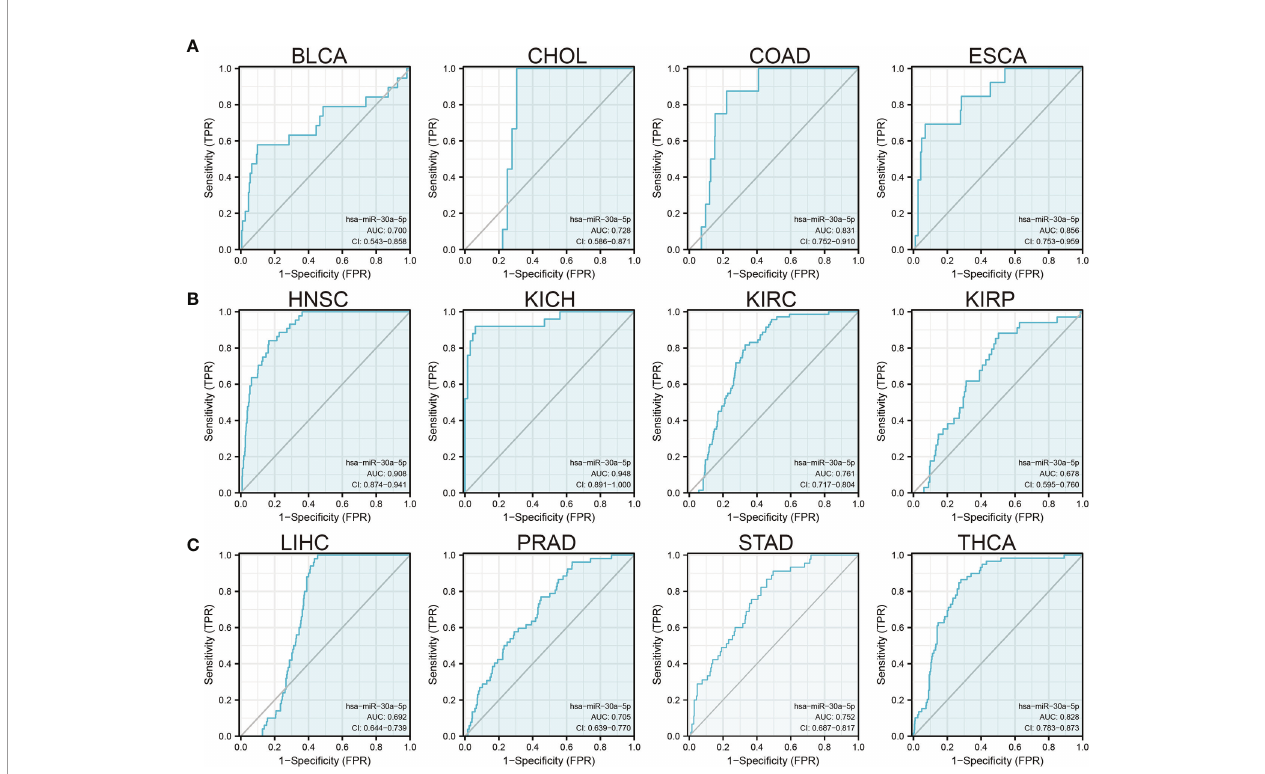
FIGURE 2 | Analysis of the ROC curve for miRNA-30a-5p in human cancers. (A – C) ROC curves of miRNA-30a-5p for predicting overall survival in diverse cancer